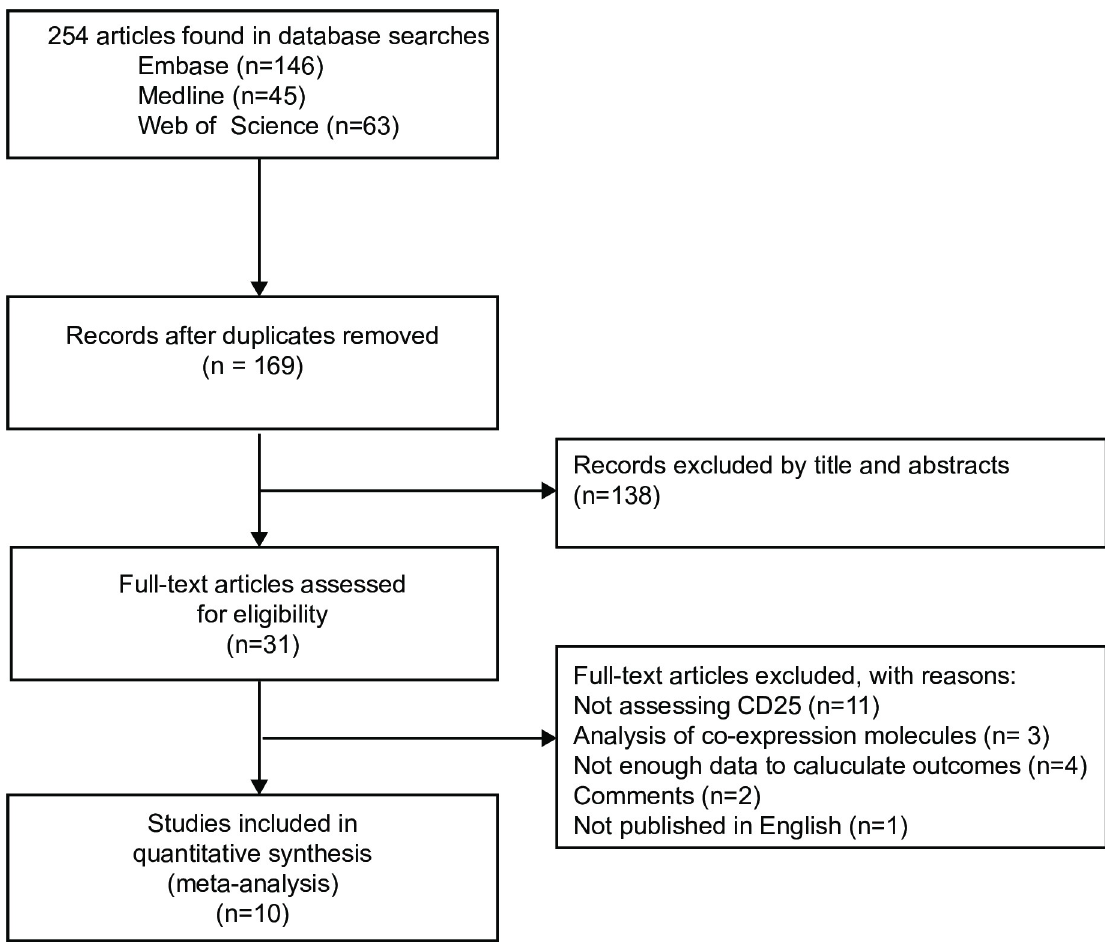
Fig 1. Flow diagram of the study review and inclusion